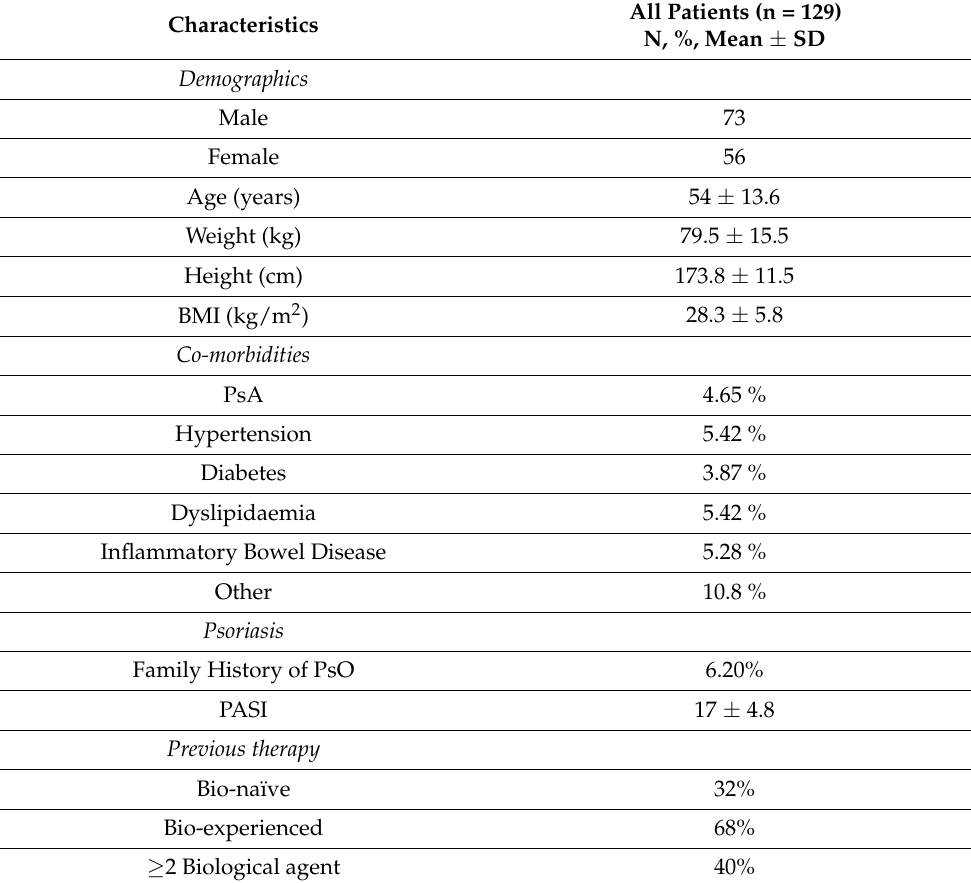
Table 1. Demographic and baseline characteristics of the study